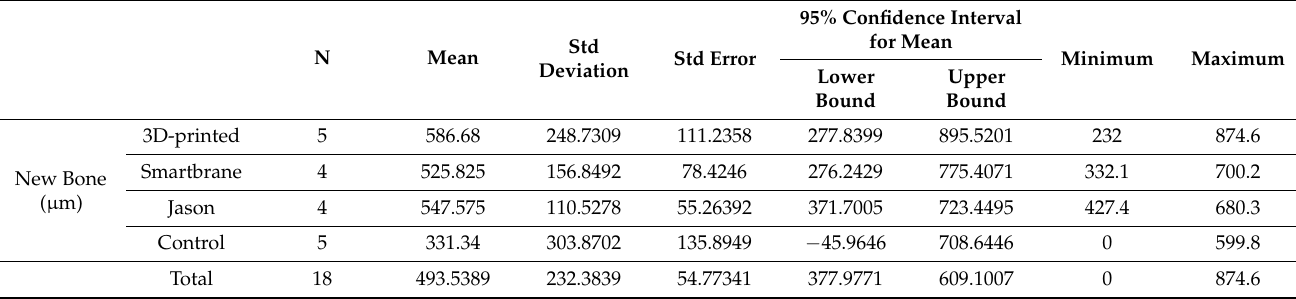
Figure 5. Comparison of maximum new bone thickness ( µ m) in the four study groups. Mean values and SD. Table 1. Histomorphometric measurements of newly formed tissues.